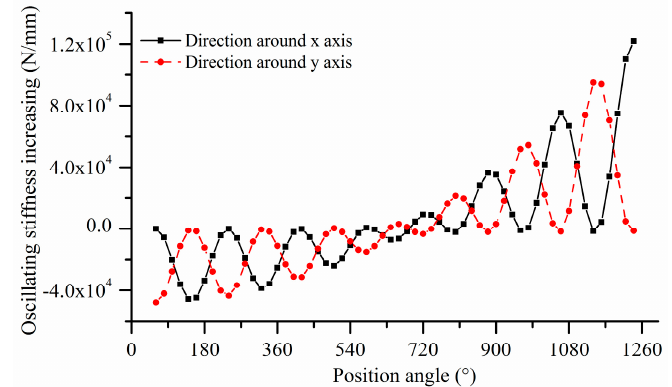
Figure 21. The di ff erence value between the local oscillating sti ff ness of each contact pair at screw Figure 21. The difference value between the local oscillating stiffness of each contact pair at screw speeds of 5000 and 500 speeds of 5000 and 500 rpm.